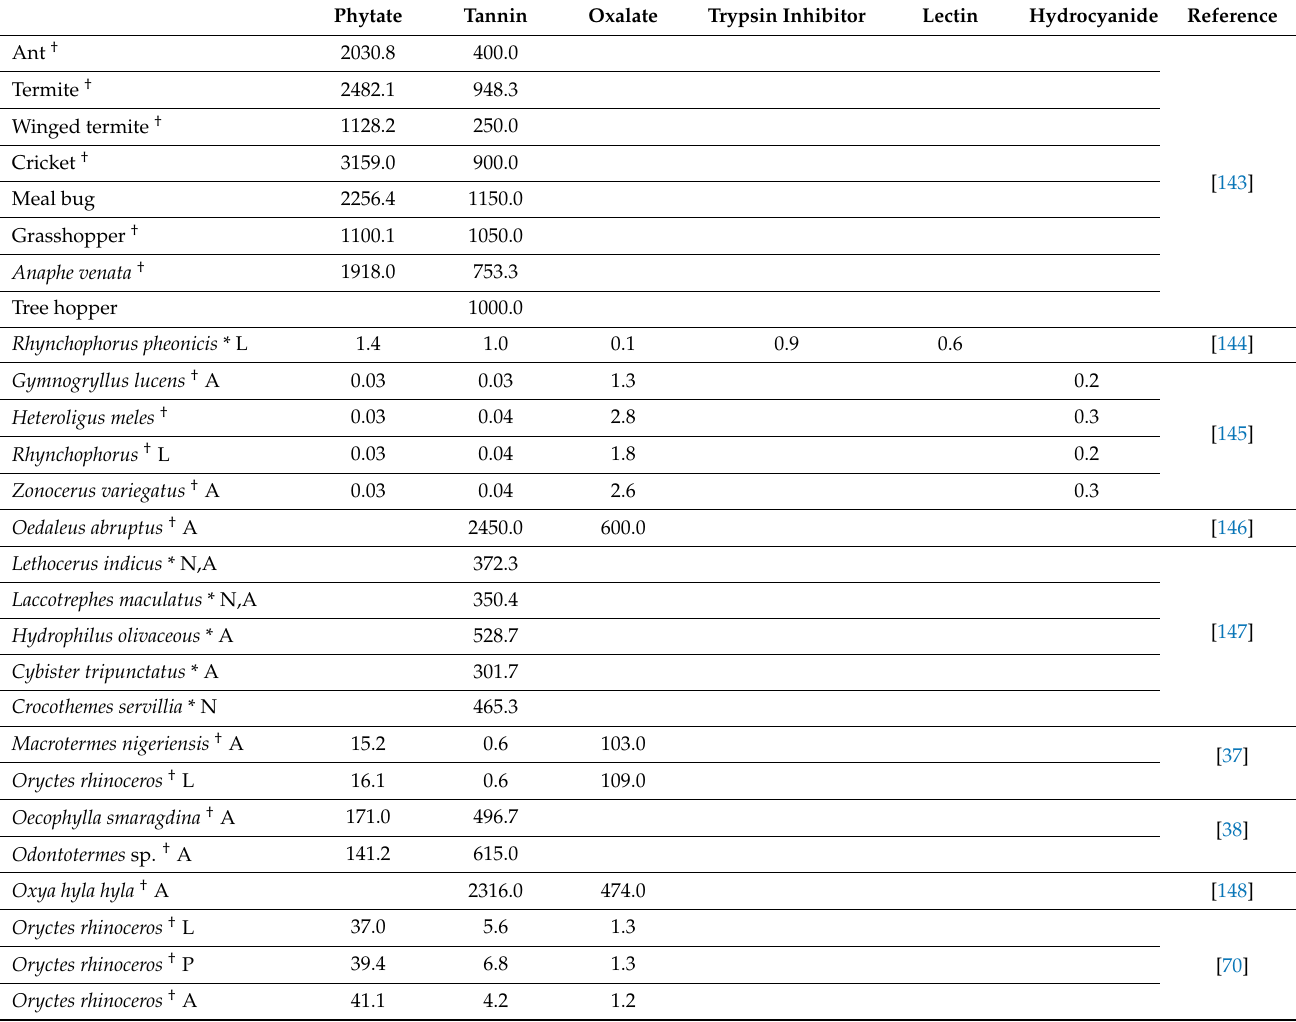
Table 7. Anti-nutrient content (mg/100 g) of selected edible insects.